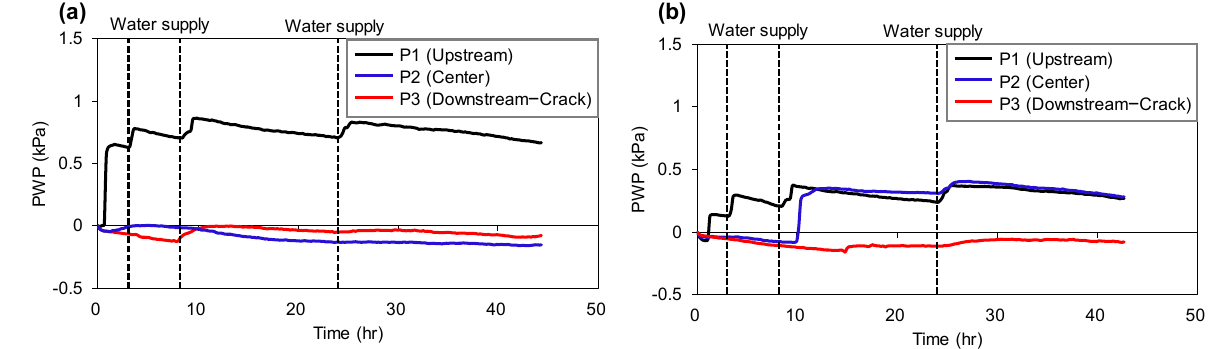
Figure 7. Changes in pore water pressure due to conduit cracking: ( a ) current model (Case 1—Crack), ( b ) improvement model (Case 2—Crack).